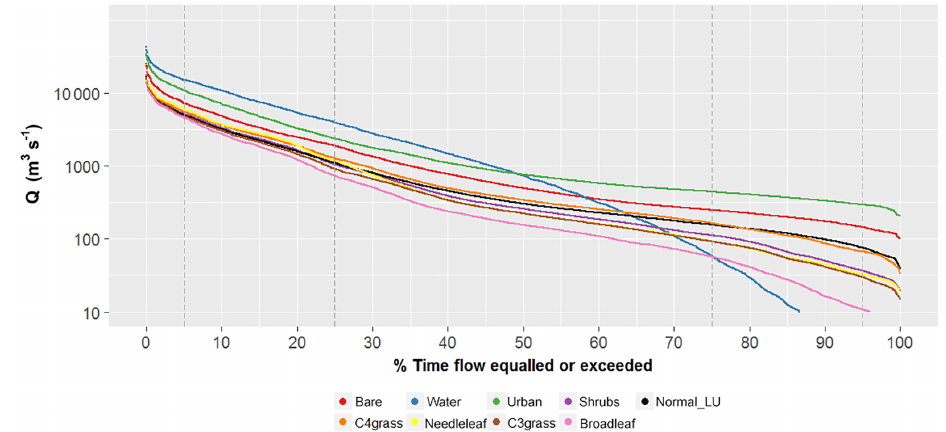
Figure B3. Flow duration curves of the streamflows simulated by JULES for the Upper Ganges basin, at Kanpur barrage, under the assump- tion that the study area was 100% covered by a particular land-cover type. For reference, the results of the run with the 2010 land-cover map are also plotted